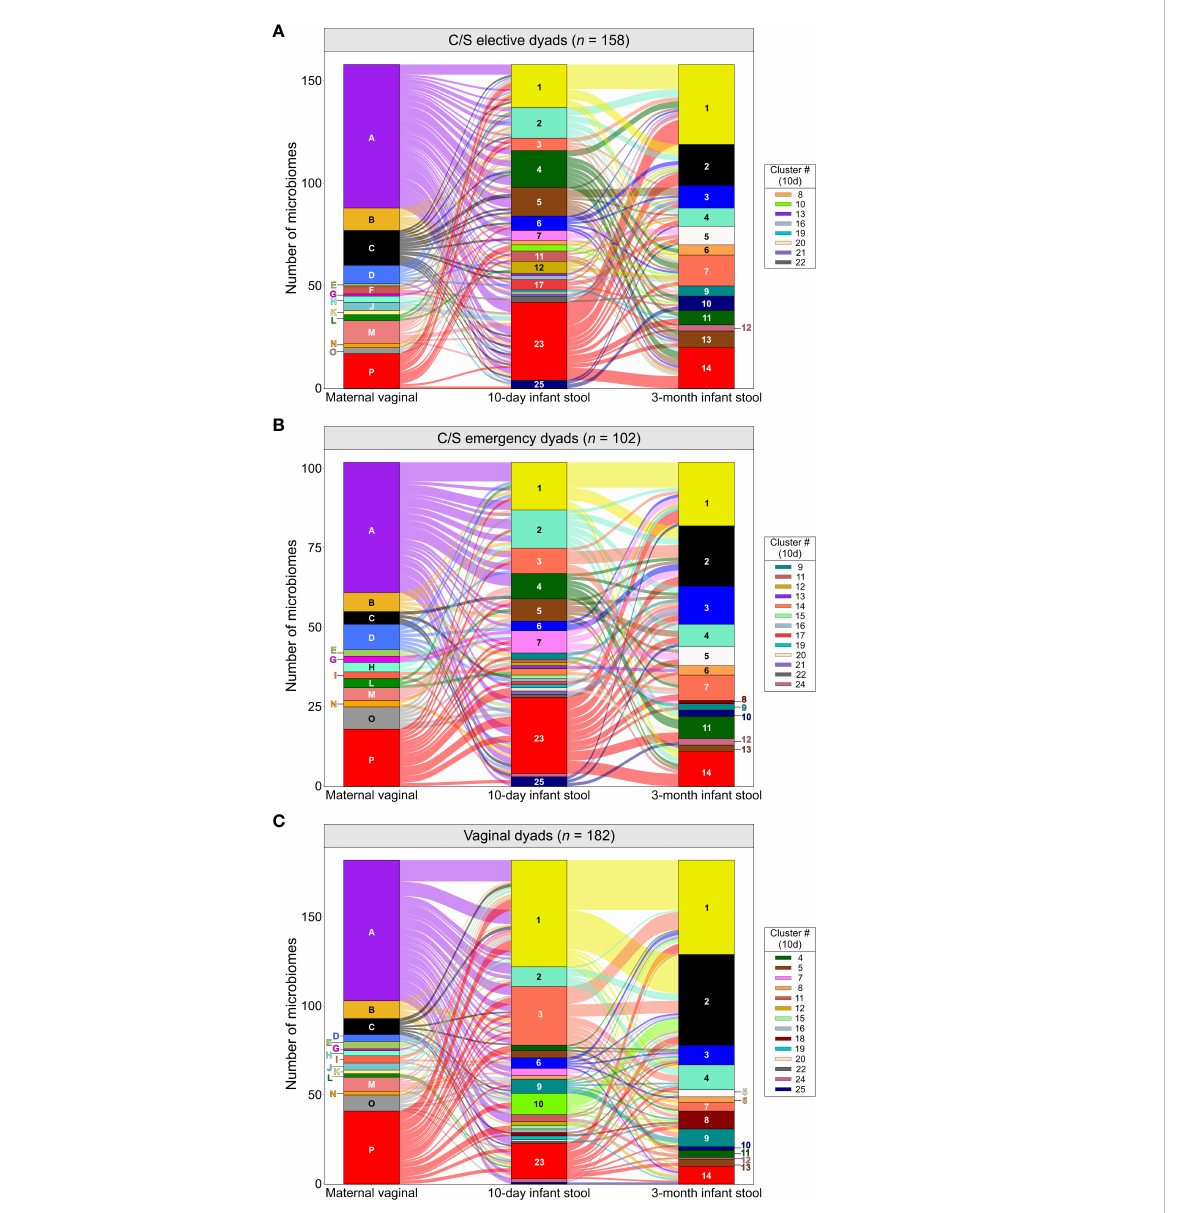
FIGURE 3 Composition of the maternal vaginal microbiome does not predict infant stool microbiome composition: Alluvial fl ow of mother-infant dyads from pre-delivery maternal vaginal microbiome clusters to 3-month-old infant stool microbiome clusters for infants delivered by elective C/S (A) , by emergency C/S (B) and vaginally (C) . Letters and numbers on stacked bars and side legend indicate microbiome clusters from Supplementary Figure S1 and Figure 1. See Supplementary Figure S9 for colour